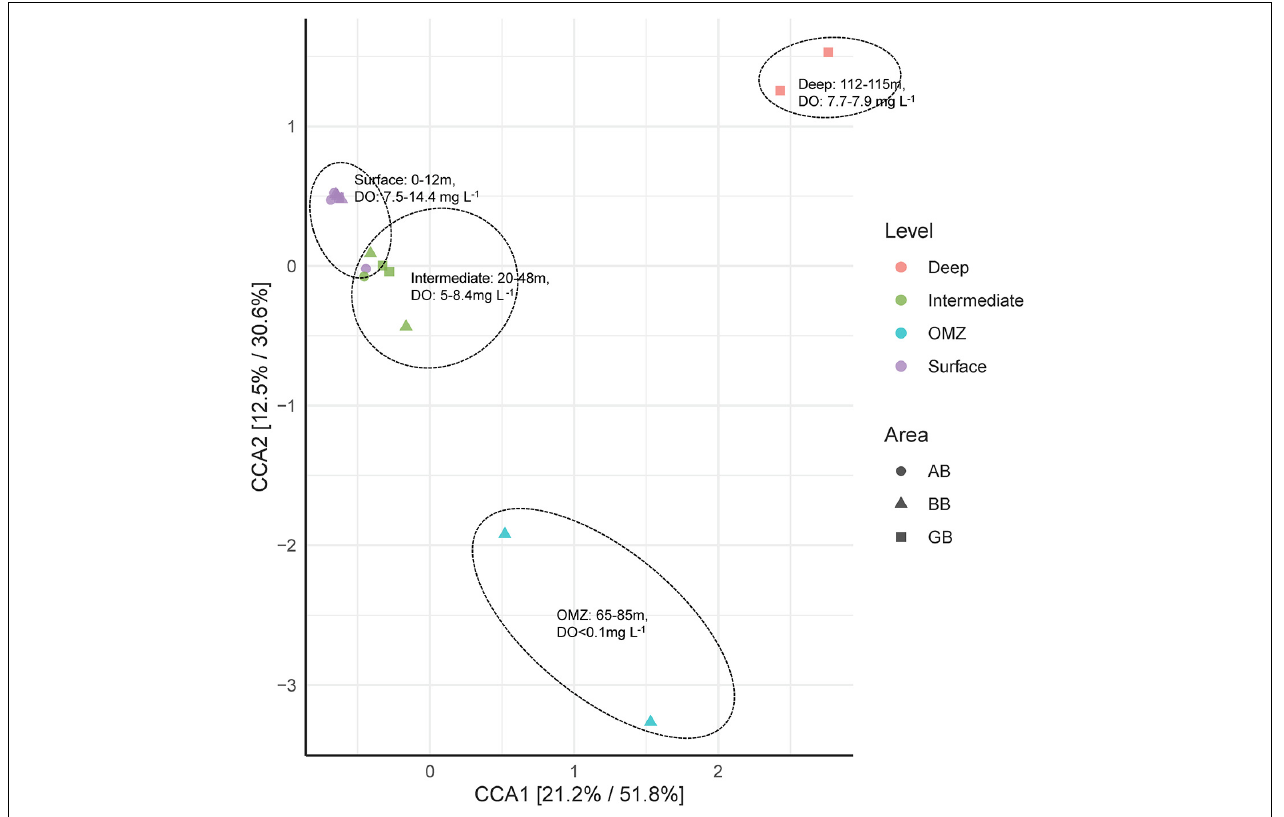
FIGURE 3 | Canonical correspondence analysis (CCA) plot depicting microbial composition from four groups of water areas (surface; intermediate; OMZ; deep) across three basins (AB, BB, and GB) in the Baltic